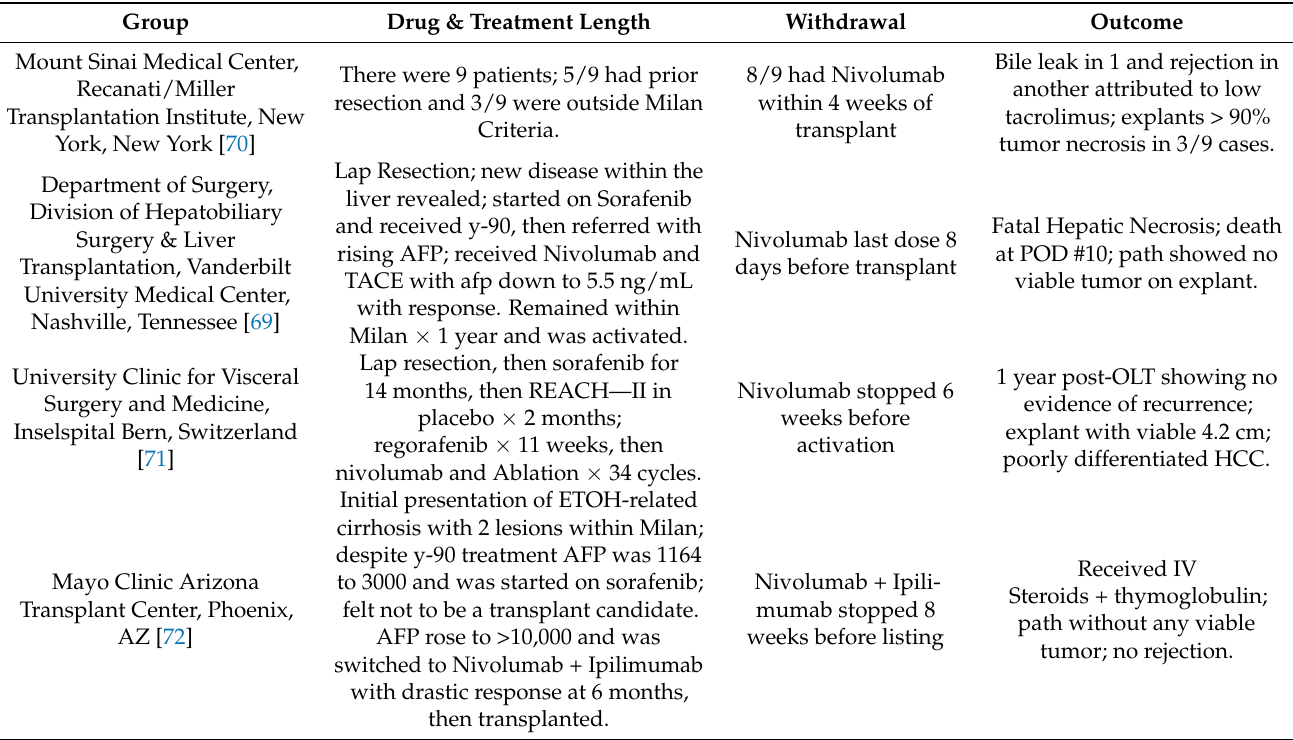
Table 3. Case Reports of Neoadjuvant Immunotherapy